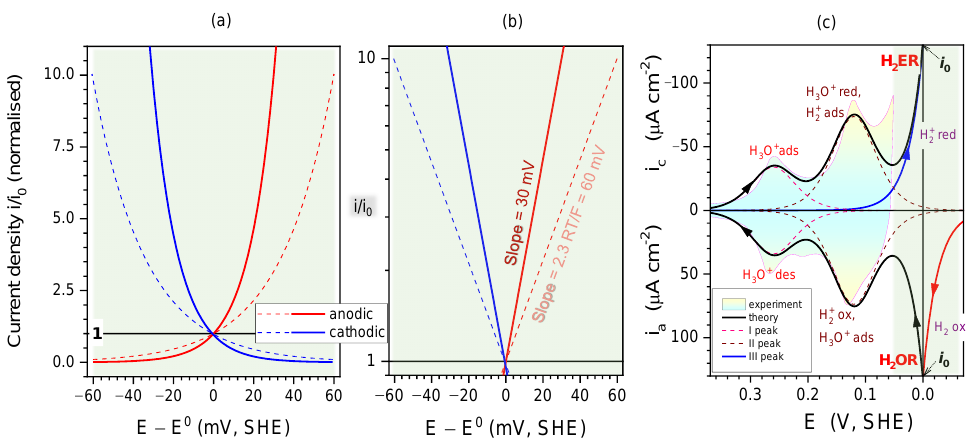
Figure 2. Analysis based on the Nernst equation for reaction (7). ( a ) The reversible polarization curves on Pt modelled for one- (dashed trace) and two-electron (solid trace) transfer processes according to Equation (20). ( b ) The log-line presentation of the same graph ( a ) to reveal the linear slope; i 0 is the exchange current. In experiments [19–21], the slope of 30 mV/dec was determined (solid lines). ( c ) Surface processes leading to H 2 ER at 0 V. The proposed model is quantitatively matching the experiment of charge and mass changes on the electrode as shown by modelling based on the Nernst equation (adopted from [37]): adsorption and red/ox reactions of ions H 3 O + and H + on Pt. The potential locations of the adsorbed (ads), desorbed (des), reduced (red) and oxidised (ox) species are shown by the corresponding